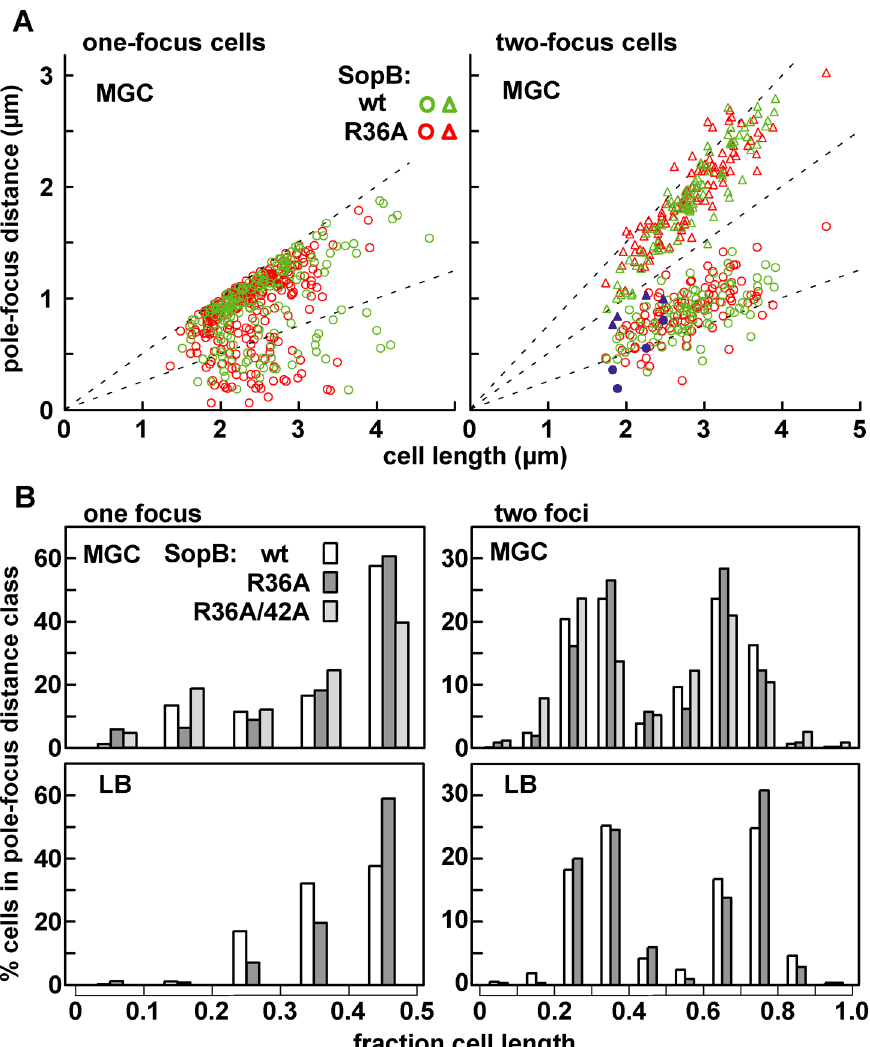
Figure 5. Limited effect of R36A mutation on mini-F positioning. The distance between the pole nearest a focus and the foci in MGC-grown cells of the one- and two-focus classes was measured. A: Pole-focus distances plotted against cell-length. The wt and R36A data-sets are superimposed. Blue symbols denote the four cases (out of 107, all R36A) in which both foci were unambiguously in the same cell-half. B: Pole-focus distances sorted into 1/10-cell intervals. In the right-hand panel distances to foci beyond the mid-point are measured from the same pole as the closer foci.